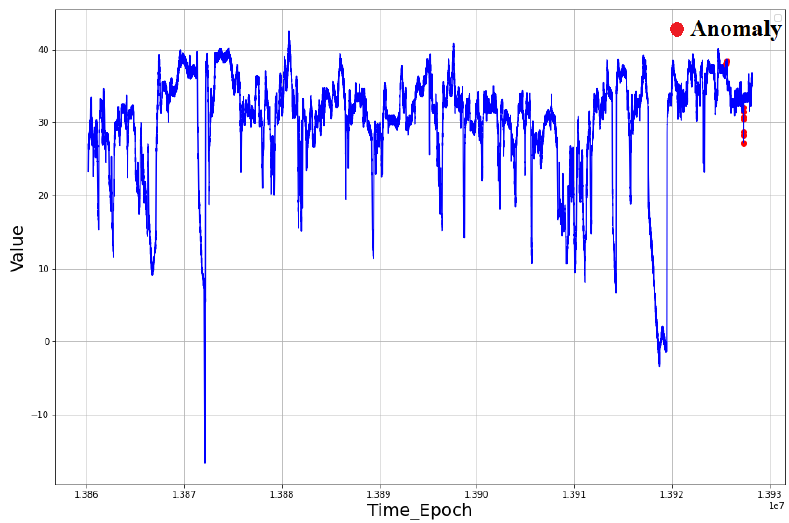
Figure 10. Anomaly detection for temperature fault.